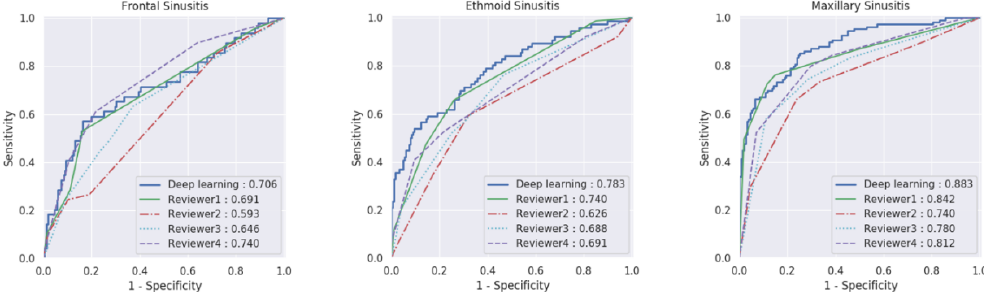
Figure 4. Receiver operating characteristic (ROC) curves and the area under the ROC curves (AUCs) of the proposed multi-view model and reviewers in the observer performance study. Table 3. Performance of deep learning model and radiologists in diagnosing multiple